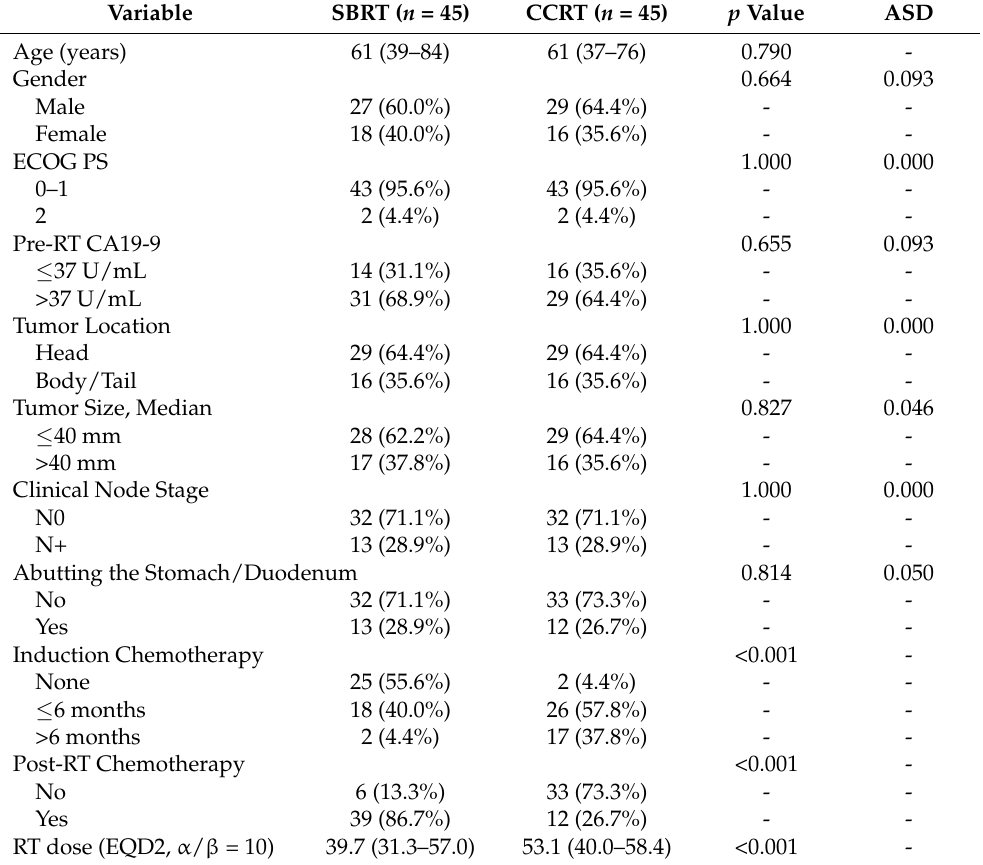
Table 4. Characteristics of the propensity score-matched cohort at the time of